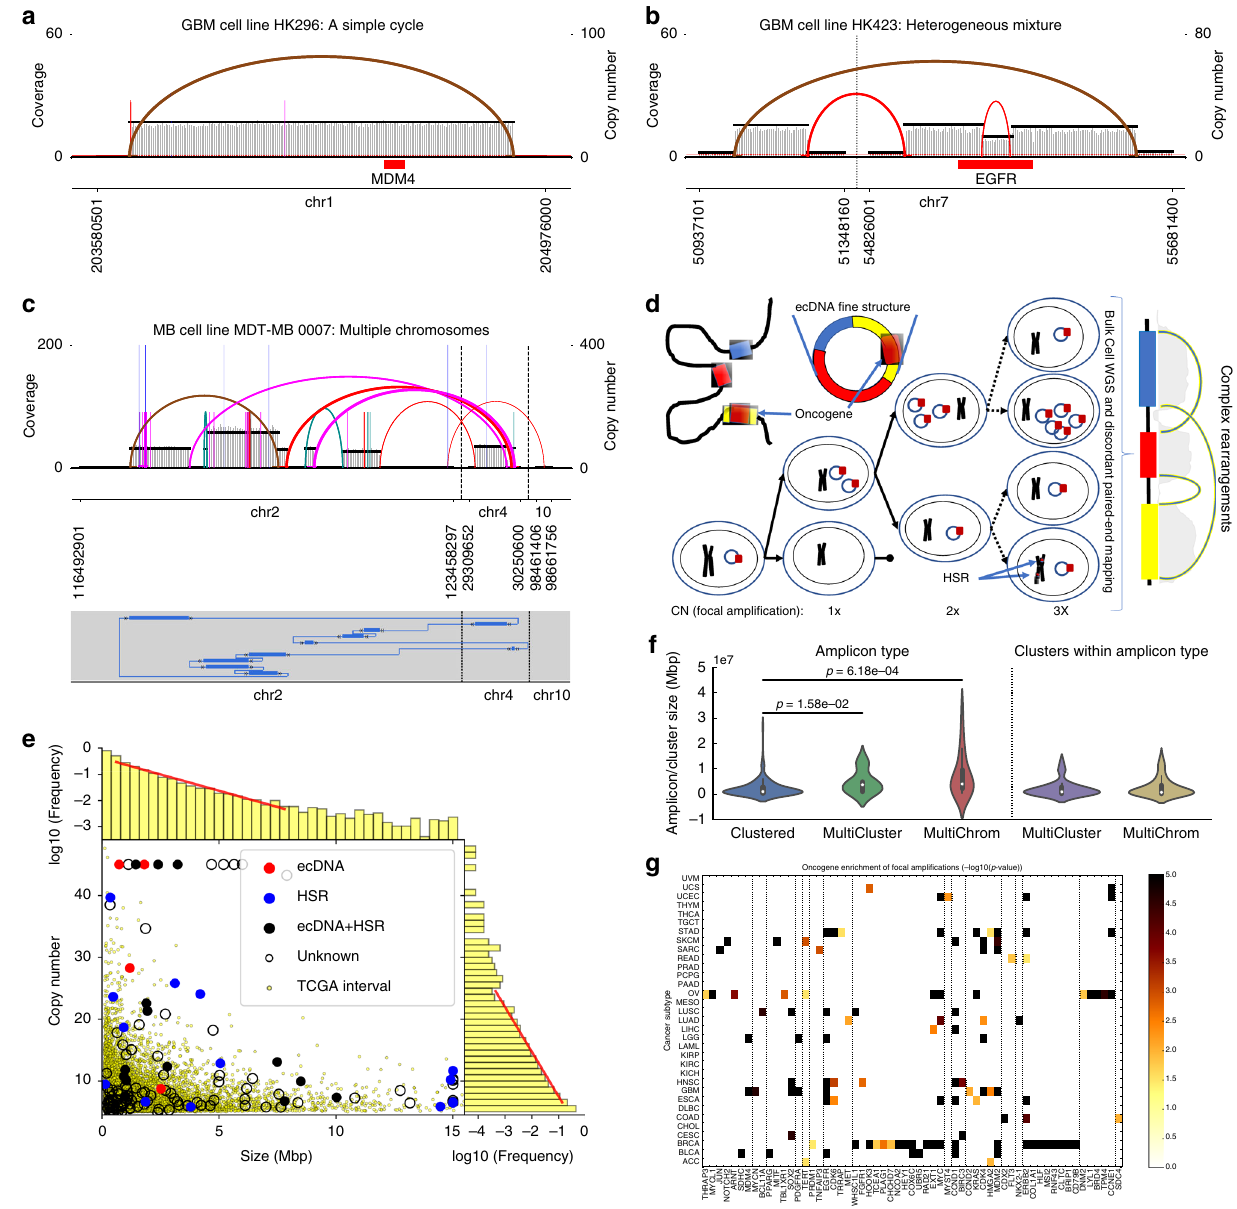
Fig. 2 Structural variant (SV) view of AmpliconArchitect (AA) reconstructions. The SV View of reconstructed amplicon structures shows a simple cycles; b heterogeneity with amplicons containing Epidermal Growth Factor Receptor ( EGFR ) VIII deletion, as well as the intact EGFR ; and c SV view and Cycle view of the complex medulloblastoma multi-chromosomal ampli fi cation. d A model for extrachromosomal DNA (ecDNA)-mediated focal ampli fi cation. e AA ampli fi ed intervals compared against 12,162 ampli fi ed TCGA intervals shows signi fi cant overlap. The interval sizes (mean 1.74 Mb) and copy numbers (mean 3.16 copies) are exponentially distributed, with no clear distinction between homogenously staining region (HSR) and ecDNA amplicons (Supplementary Data 4). f Amplicons containing multiple genomic regions from the same chromosome (MultiCluster) or multiple chromosomes (MultiChrom) are signi fi cantly larger in size ( p- value < 0.016, Wilcoxon Rank-Sum test) than amplicons containing intervals from a single chromosomal region (Clustered). However, the size distribution of individual intervals in clustered amplicons is similar to the size distribution of intervals in MultiChrom or MultiCluster amplicons (Supplementary Data 4). g Heatmap of negative log p -values (Bonferroni-corrected Poisson Binomial) showing enrichment of 59 oncogenes in ampli fi cations in 33 cancer types. Source data are provided in a Source Data fi